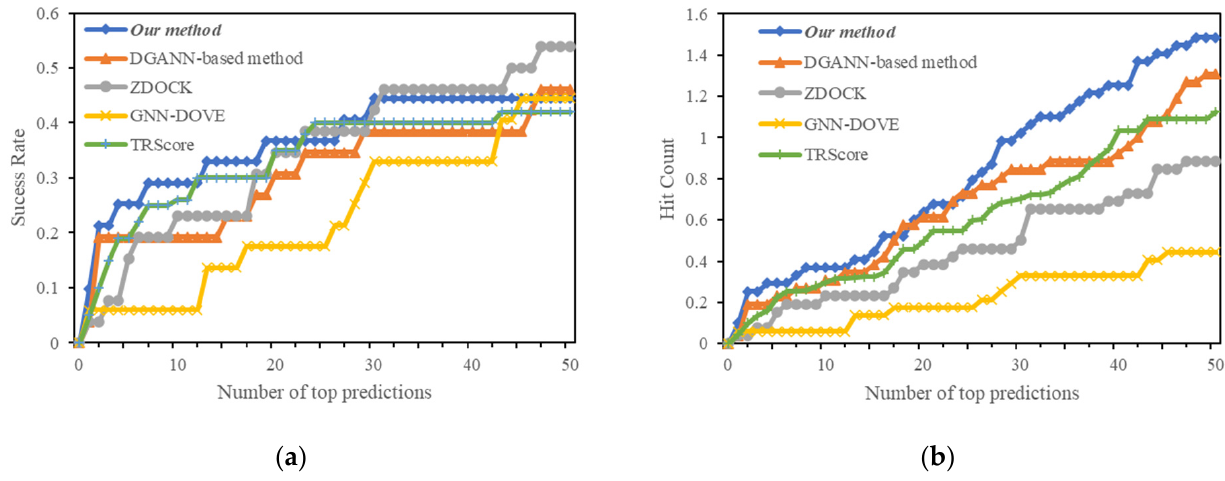
Figure 6. Comparison of our scoring function with DGANN-based method, ZDOCK, GNN-DOVE and TRScore for the ZDOCK benchmark 5.5. ( a ) Success rates of di ff erent methods. ( b ) Hit counts of di ff erent methods.